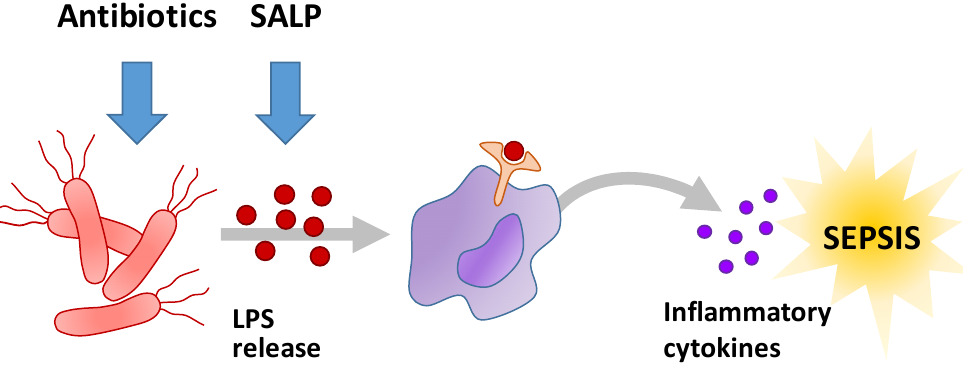
Figure 1. General mechanism of sepsis initiation caused bacterial infections and the target points of antibiotics and the LPS neutralizing icosapeptide Pep19 ‐ 2.5.